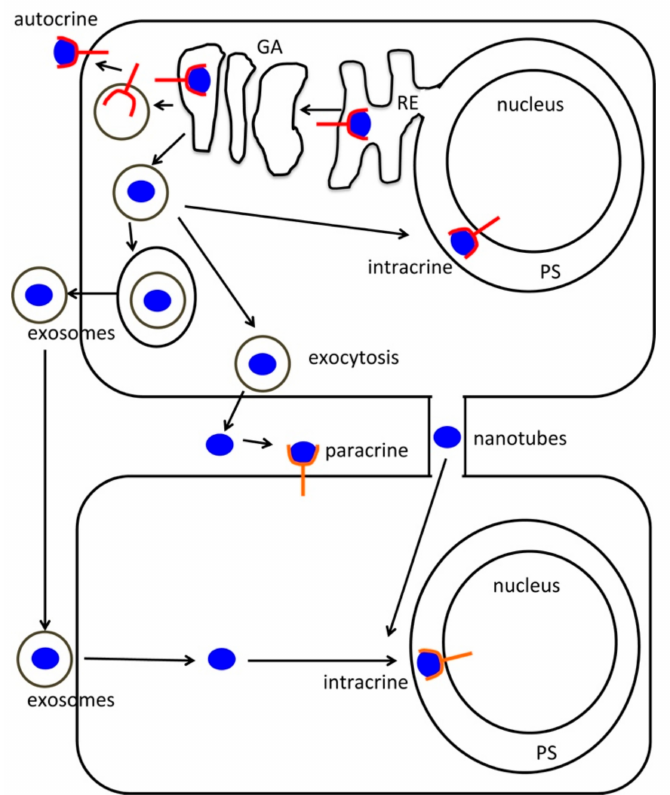
Figure 1. Intracrine patterning. The figure depicts a scheme of intracrine signaling within the context of intra- and extra-cellular communication via paracrine, autocrine, and exosomal routes. GA: Golgi Apparatus; RE: Endoplasmic Reticulum; PS: Perinuclear Space; red shape: receptor; blue shape: